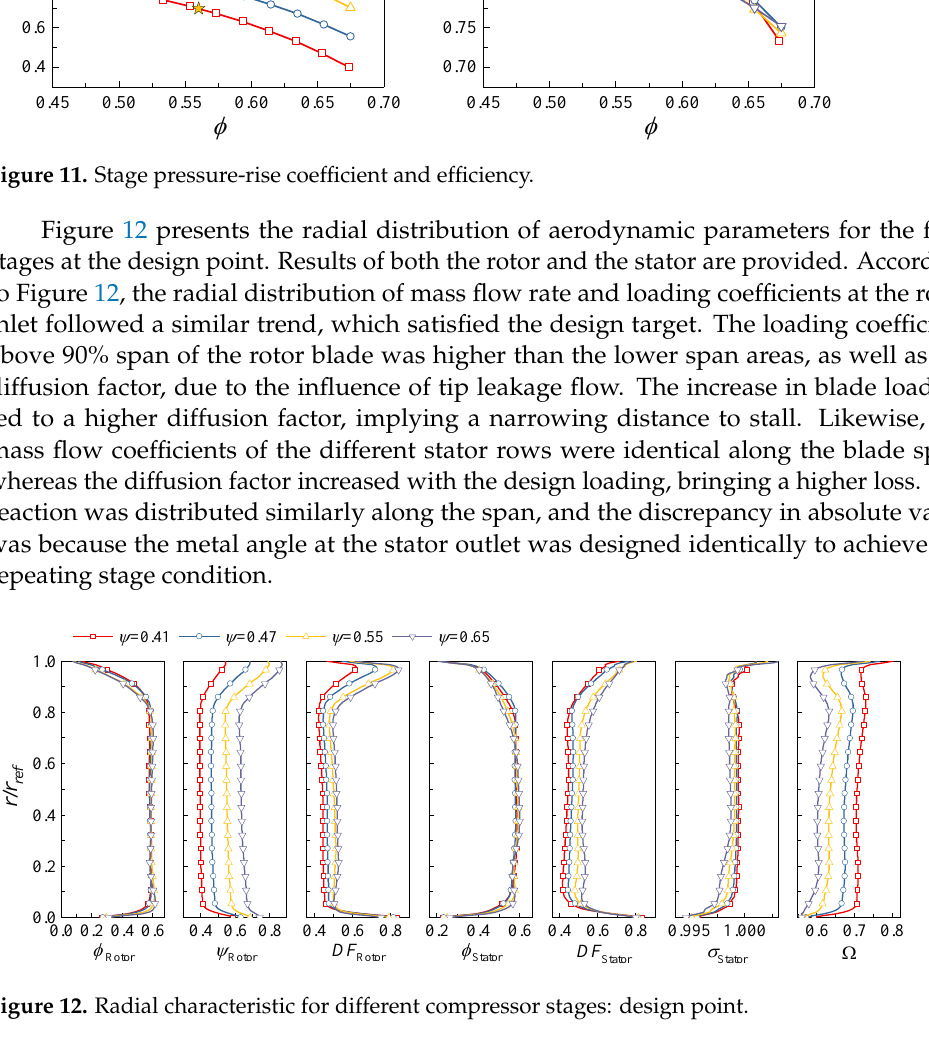
Figure 13. Spanwise aerodynamic performance for different compressor stages: near-stall point. In summary, the four ultrahigh loaded compressor stages resembled each other and were carefully designed to avoid large-scale endwall corner separation flow. The flow matching in the radial direction is reasonable enough for a high-performance compressor. A further comparison can help to reveal the unique characteristics of the ultrahigh loaded compressor. 3.2. The Decomposition of the Flow Loss To reveal the influence of stage loading on the compressor loss characteristic, the total loss was decomposed using an improved method presented by To [20]. This section gives a short introduction of the decomposition method for the present study. 3.2.1. The Loss Decomposition Method According to To [20], when hub and shroud boundaries of a certain compressor stage have no interaction (which is generally true when the aspect ratio is above 0.5), the total loss in a blade row can be decomposed as the endwall loss and the freestream loss. The freestream loss is essentially the blade profile loss, whereas the endwall loss includes the effect of the endwall boundary layer and the tip leakage flow. Under the incompressible